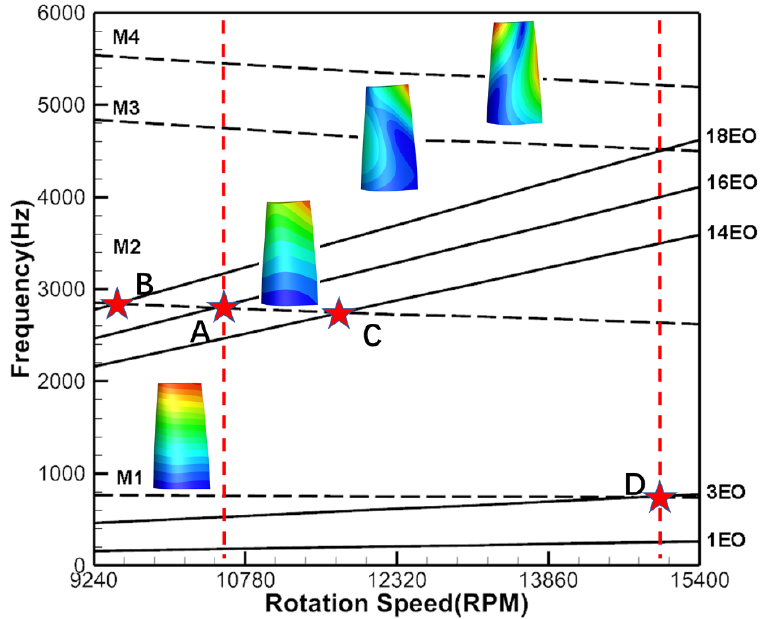
Figure 6. Campbell